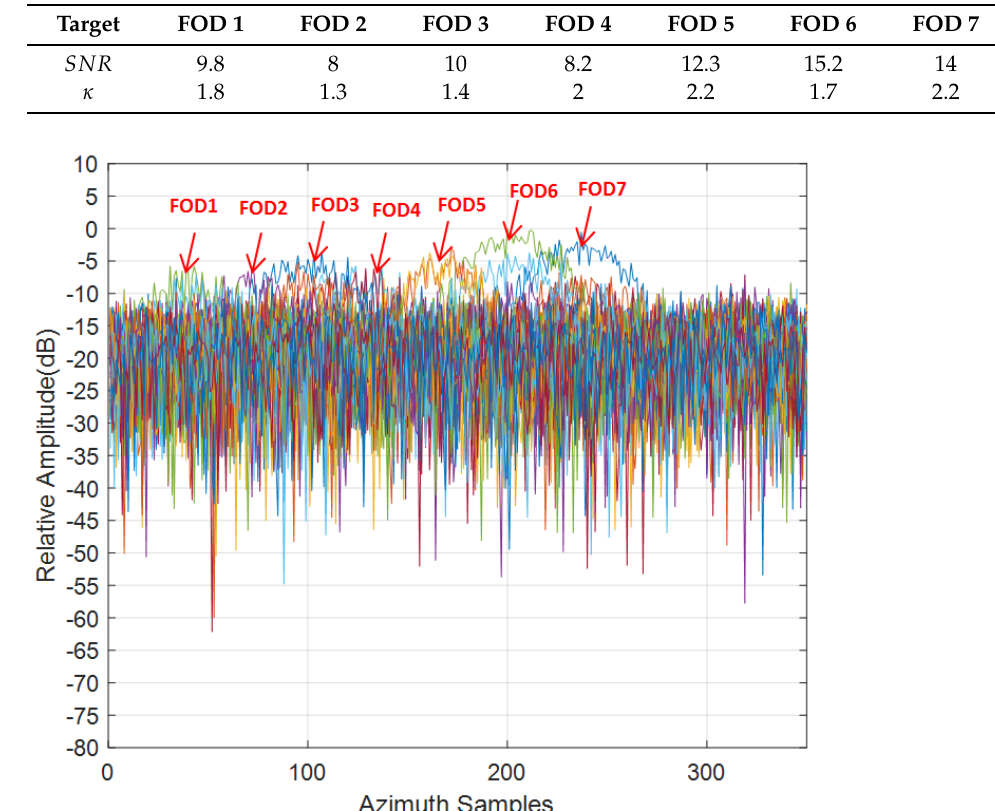
Table 3. Super-resolution ratio statistics of the FOD targets in Scene 2.